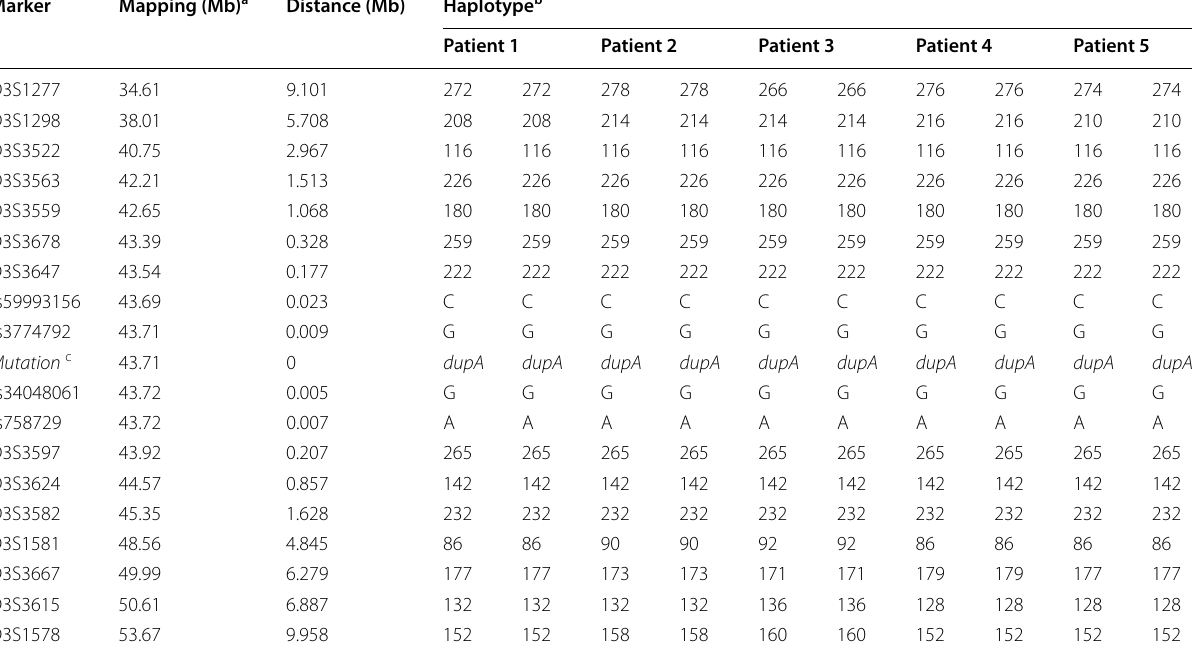
Table 3 Disease-linked haplotypes for 4 intragenic single nucleotide polymorphisms and 14 flanking microsatellite markers from chromosome 3p22.3 ‒ 3p21.1